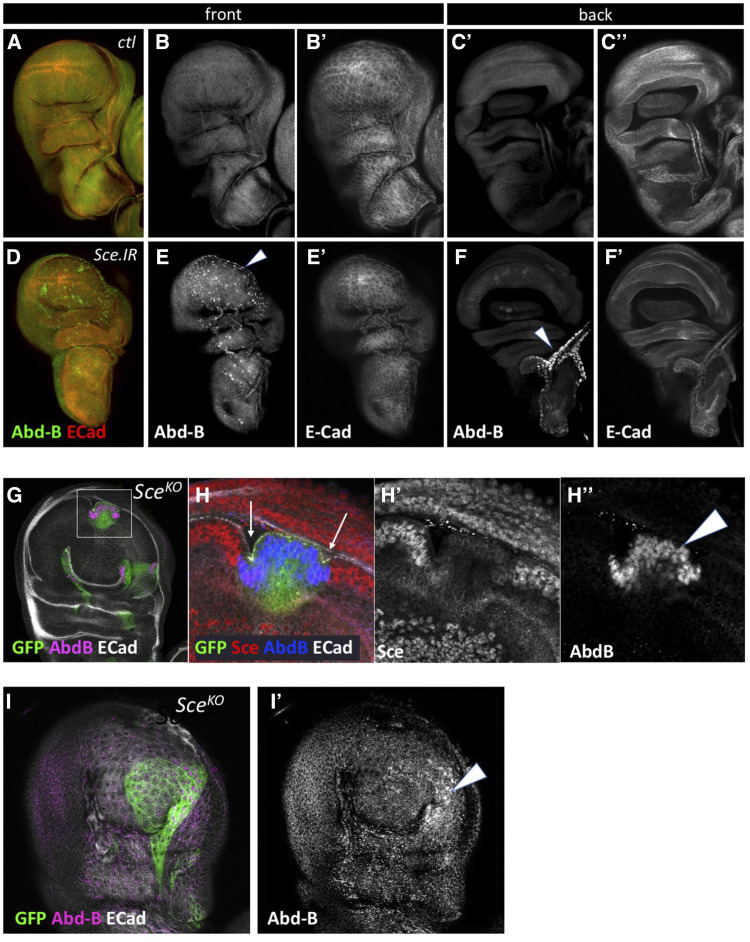
Sce represses Abd-B. (A-F) Third instar wing discs stained for Abd-B and E-Cadh. In control discs (A-C) no expression of Abd-B is detected. In Sce.IR discs, Abd-B is expressed in nuclei throughout the PE (E, arrowhead), and the tracheal branch on the side of the discs, opposite to the PE (F, arrowhead). (G-I) MARCM clones of Sce show clear upregulation of Abd-B in both the disc proper (H’’, arrowhead; I’, arrowhead) and PE (I’, arrowhead). Sce expression is clearly lost from MARCM clones (H’). MARCM clones show distinct morphological changes with invaginations at the boundary with surrounding heterozygous cells (H, arrows), and a smoother, more rounded profile in the PE (I, green).